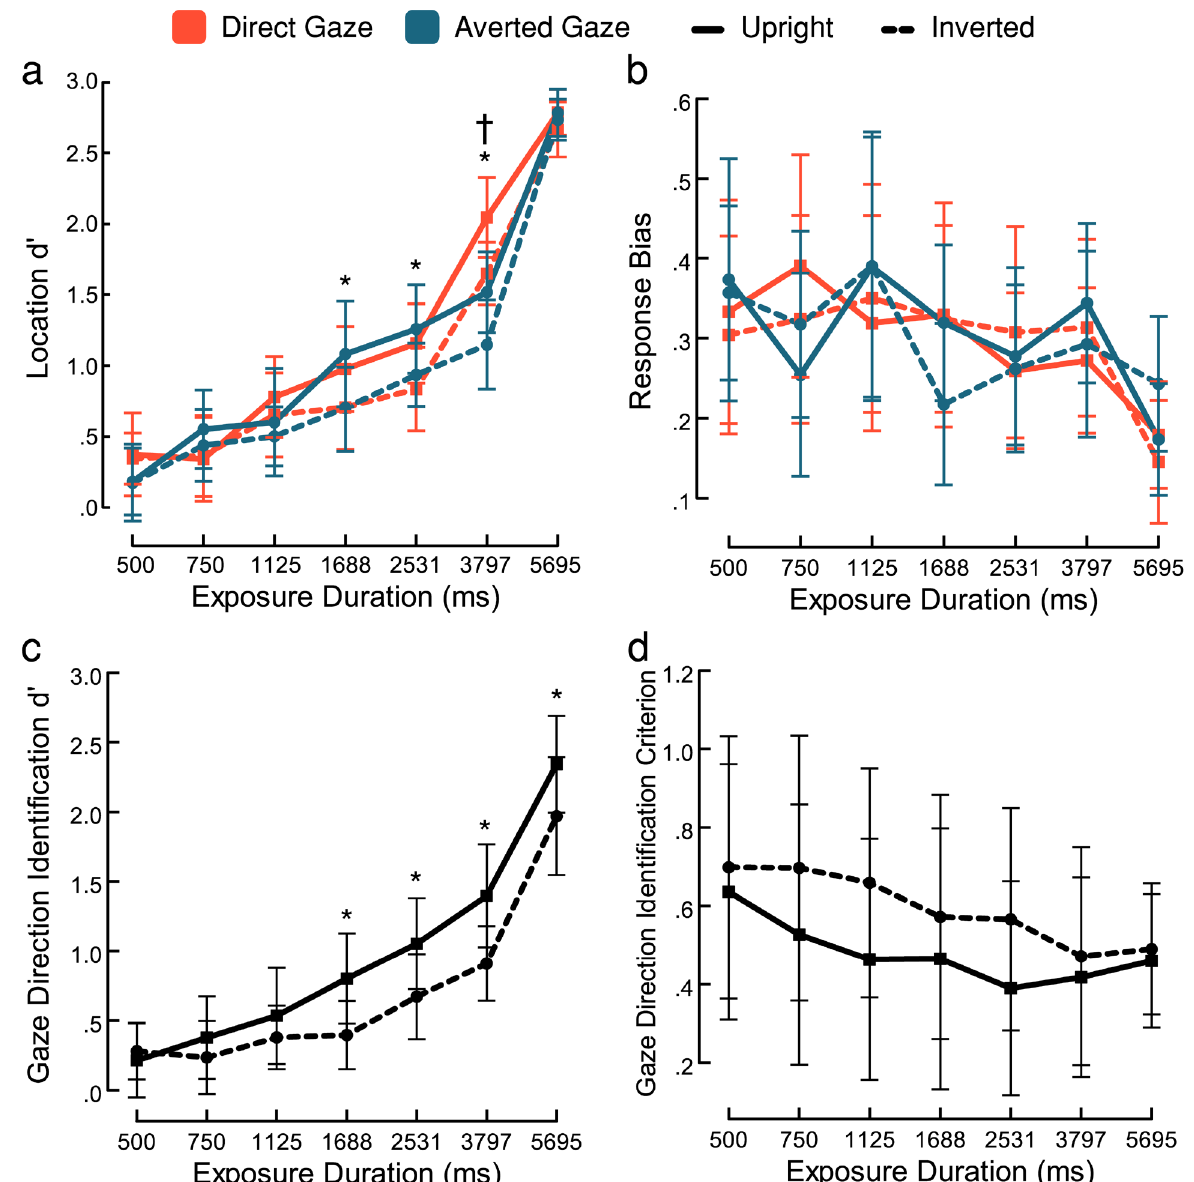
Figure 4. Results of Experiment 2. ( a ) Location sensitivity: d’ increased with exposure duration. A significant advantage for direct-gaze faces over averted-gaze faces is present at 3797 ms of exposure. A significant advantage for upright faces over inverted faces is present at 1688, 2531, and 3797 ms of exposure. ( b ) Absolute-value response bias scores for reporting location: bias decreased as exposure duration increased, but there was no difference in amount of response bias between gaze and orientation categories. ( c ) Identification sensitivity for gaze direction: identification d’ increased with exposure duration, and d’ was significantly greater for upright faces than inverted faces from 1688 ms of exposure. ( d ) Criterion scores for reporting direct gaze: upright faces exhibit a significantly more liberal criterion than inverted faces. Asterisks index statistically significant differences between face orientations. Daggers indicate statistically significant differences between gaze directions. Error bars represent 95%